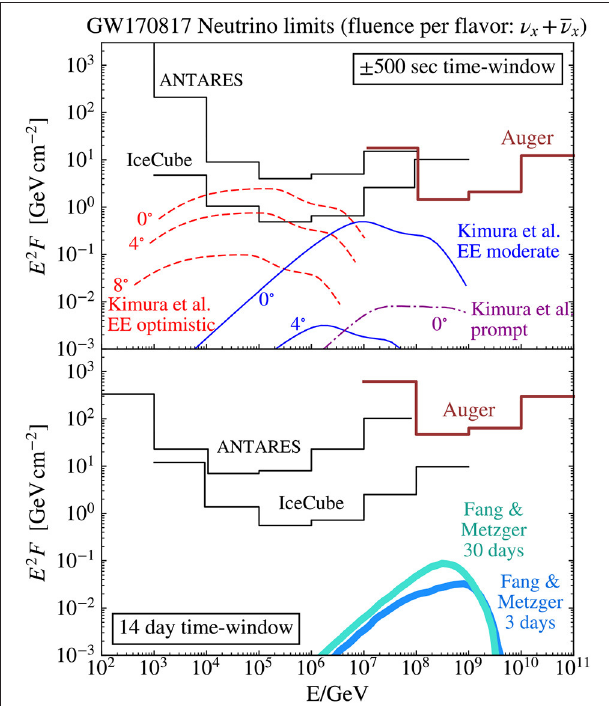
FIGURE 4 | Upper limits at 90 % C.L. on the neutrino spectral fluence from GW170817 for a 1,000 s period centered at (14 day after) the time of the event in the top (bottom) panel. The bounds in the top panel are compared to predictions of models of prompt and extended emission (EE) (Kimura et al., 2017 ) in the case of exact alignment of the line of sight to the rotation axis and for selected off-axis viewing angles. The bounds obtained for a 14-day period on the bottom panel are compared to models of longer lived emission ( Fang and Metzger, 2017 ). All models have been scaled to 40 Mpc, the distance to the host galaxy NGC 4993 (Modified from Albert et al.,